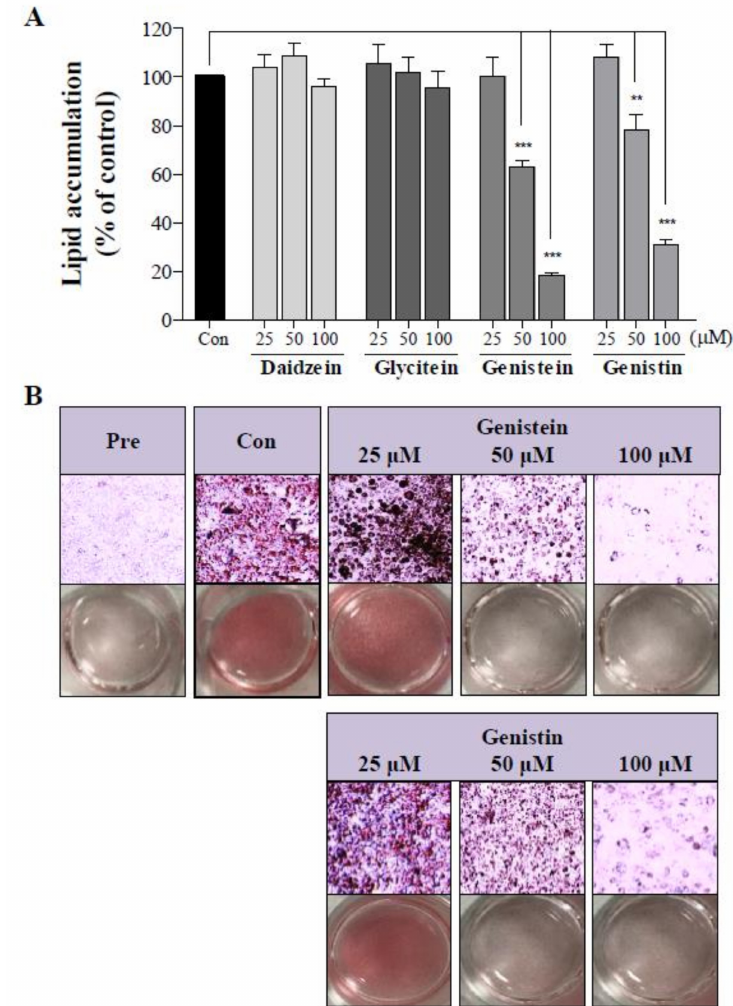
Figure 2. Suppressive e ff ect of genistin and genistein on adipocytic di ff erentiation of 3T3-L1 cells. During di ff erentiation, 3T3-L1 cells were separately treated with 25, 50, or 100 µ M of each soy isoflavone in the MDI media (a mixture of 3-isobutyl-1-methylxanthine (M), dexamethasone (D), and insulin (I)). Lipid accumulation was determined by Oil Red O (ORO) staining. ( A ) Data from ORO staining of the four soy isoflavones were quantified. All data are presented as the mean ± SD and analyzed with one-way ANOVA and compared with those from the isoflavone-untreated 5control. ( n ≥ 3, ** p < 0.005, *** p < 0.001). ( B ) ORO images of genistein- and genistin-treated 3T3-L1 cells were obtained. Pre, preadipocytes; con,